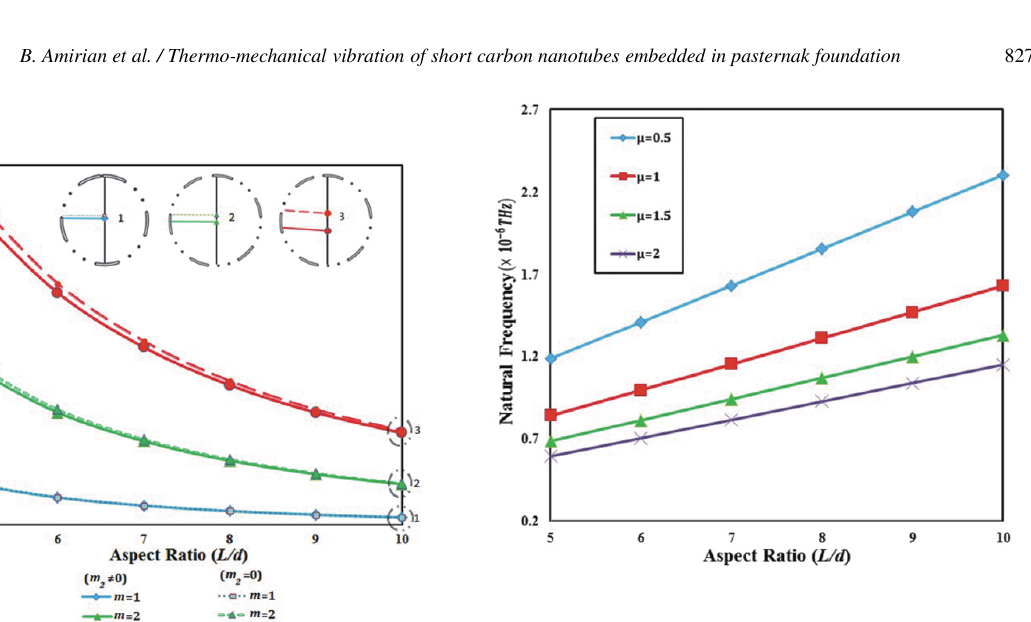
Fig. 1. Variation of natural frequency with aspect ratio L/d for differ- ent change in mode numbers, m , with/without rotary inertia, m 2 , for short-SWCNT, ( K W = K G = ¯ N = 0 ).